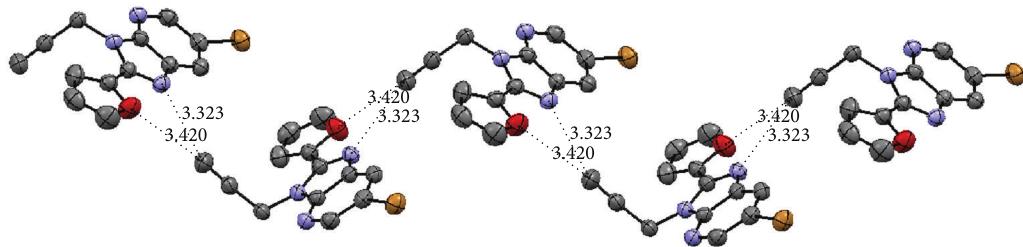
Figure 5: Intermolecular C–H ⋅⋅⋅ N and C–H ⋅⋅⋅ O interactions forming a zigzag structure along the 𝑏